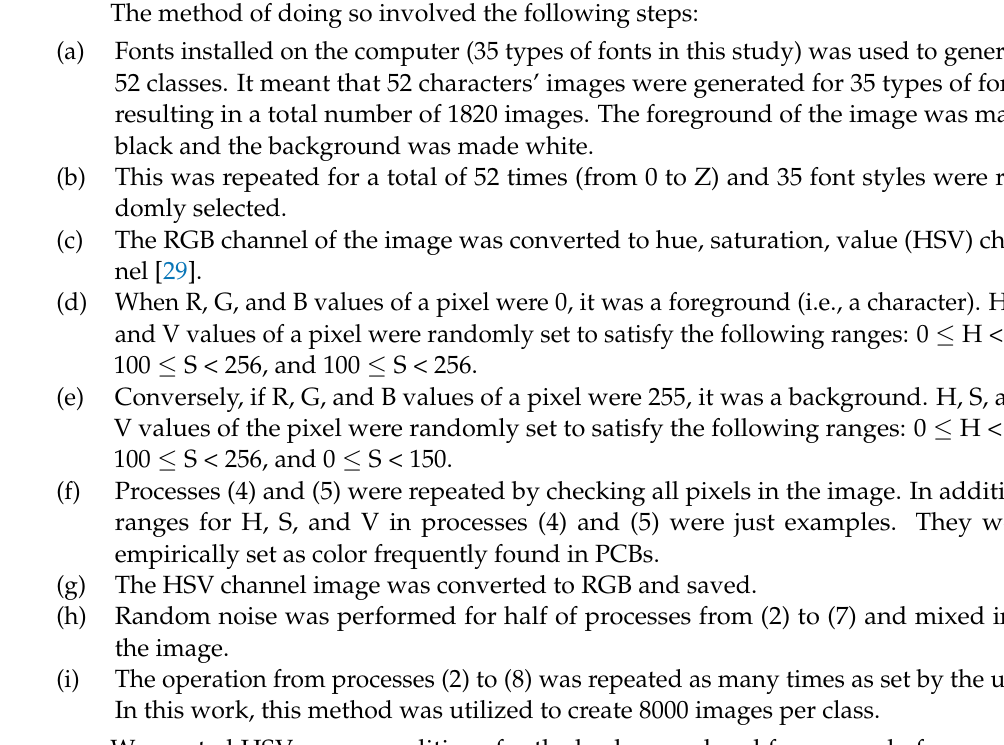
Figure 10. Creation of font data for colors appearing on PCB components in the real